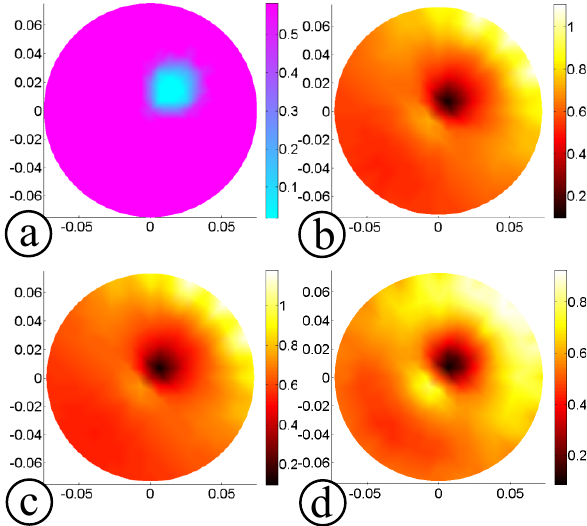
Fig.11 : Conductivity reconstruction of the phantom with inhomogeneity (D = 35 mm, L = 22.5 mm) near electrode No.-3 ( λ = 0.0001 ): (a) original object, (b) image with STR, (c) image with LMR, (d) image with BMMR. Table-7: CNR, PCR and COC of the conductivity images of Fig. -11 22.5 mm Dis t .